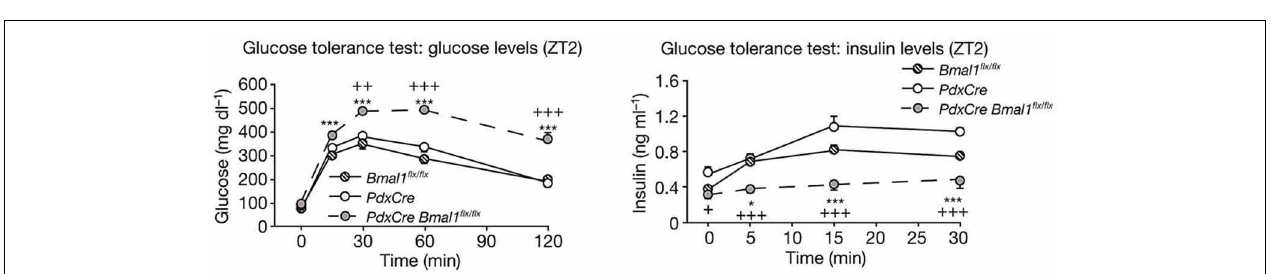
FIGURE 2 | Clock genes and physiological function. The core clock is composed by the Per, Cry, Bmal1, and Clock clock genes (Okamura et al., 2010; Takeda and Maemura, 2011). BMAL1 and CLOCK activate transcriptional levels through E-boxes, and CRY and PER suppress this activity. Cis elements such as RORE and D-box can be regulated by ROR, REV-ERB, DBP, and E4BP4, and multilayered rigid circadian